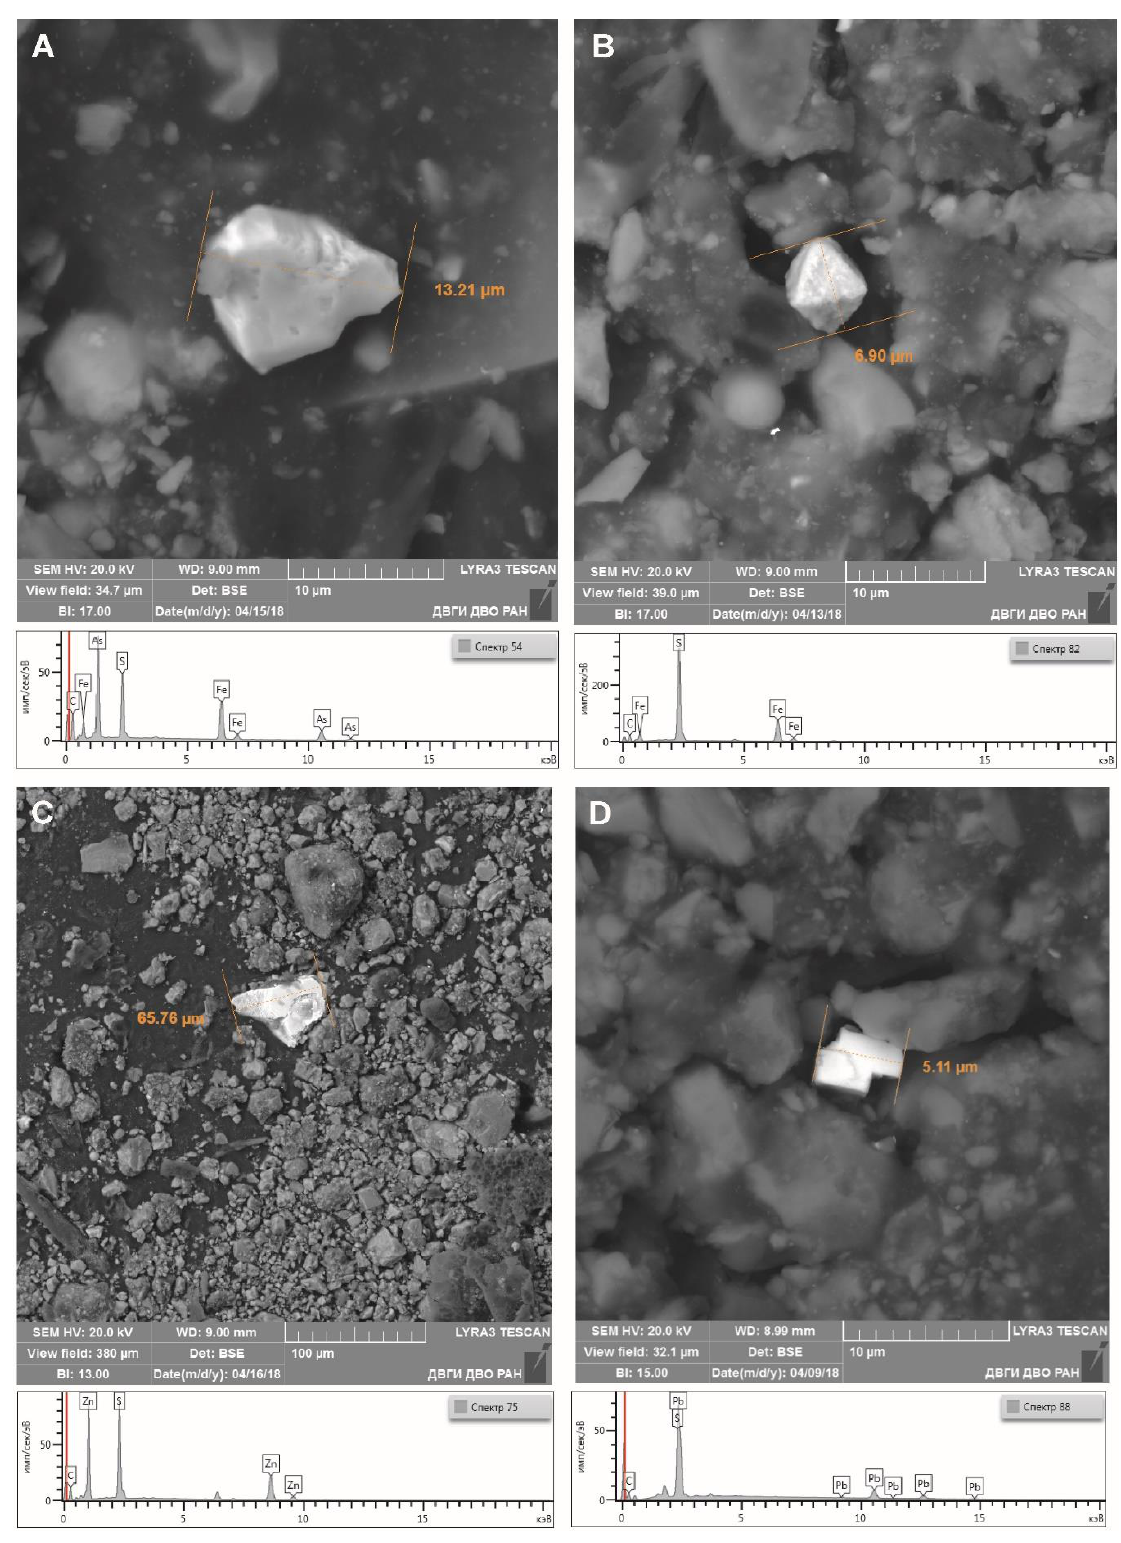
Figure 4. Morphology and chemical composition of Fe, As, Zn, Pb, and S dust particles represented by: ( A ) arsenopyrite (washout sample No. 3); ( B ) marcasite (sample No. 2); ( C ) sphalerite (sample No. 3); and ( D ) galena (sample No. 1). In addition, the studied samples contained clusters of spherical particles represented by iron oxide, probably magnetite (Figure 5A,B), and also cassiterite (SnO 2 ) containing up